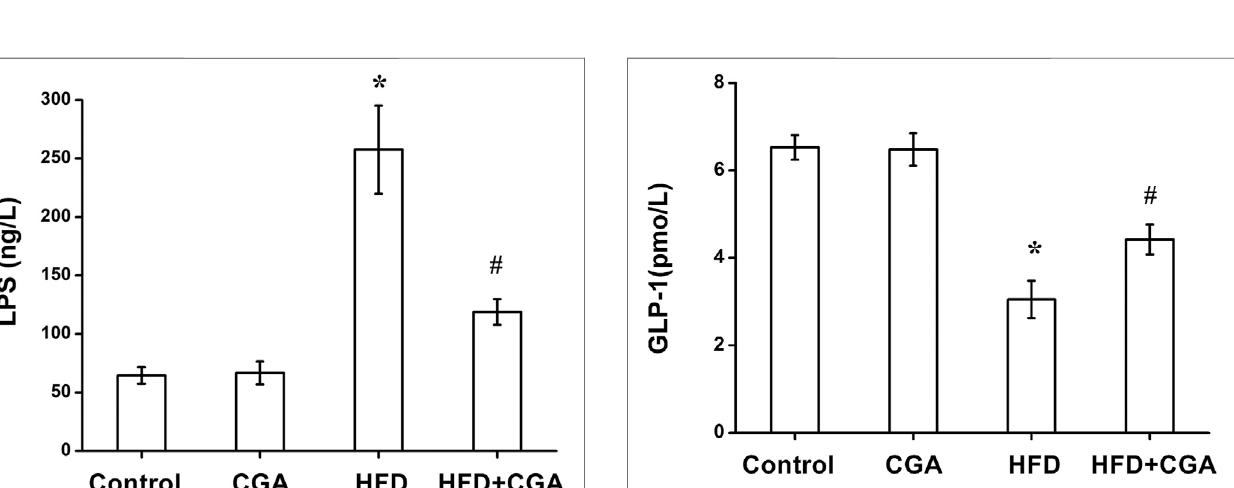
FIGURE4 | Effect ofCGA on the expression of intestinal tightjunction protein. (A) Immunohistochemical stainingof ZO-1 and Occludin (100 × ) (B) Mean density of ZO-1 analyzed with Image-Pro Plus. (C) Mean density of Occludin analyzed with Image-Pro Plus. Data are presented as mean ± SD. * p < 0.05 as compared with the control group; # p < 0.05 as compared with the HFD group.